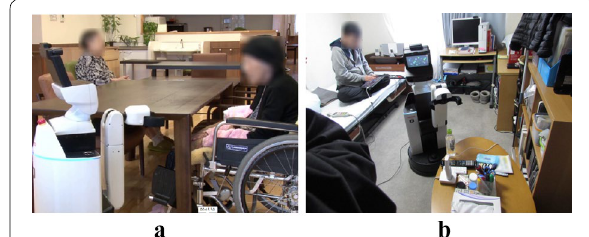
Fig. 30 Examples of field experiments. a Test in nursing facility, b Test in real house